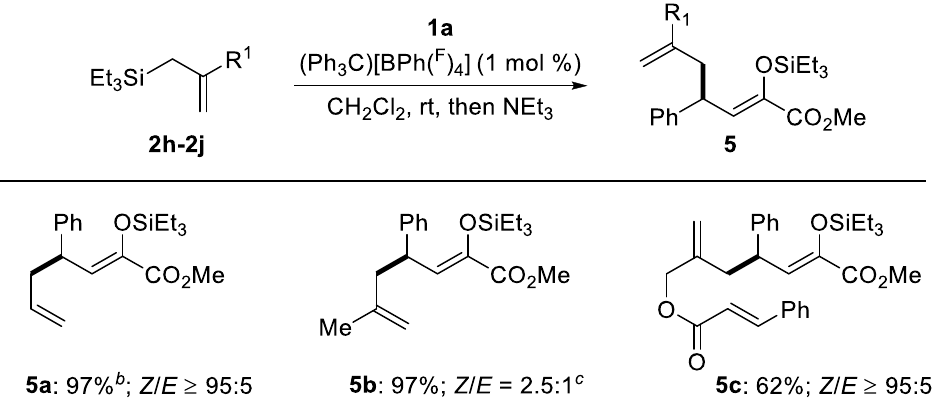
Entry allysilanes products